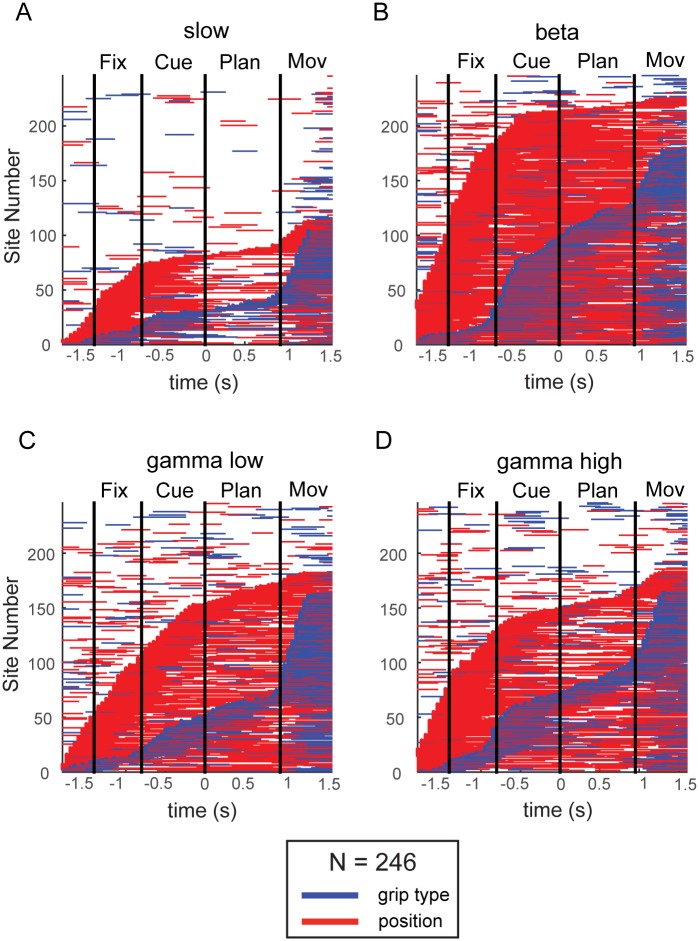
Tuning Onset.Sliding window analysis (window size 300ms, step size 50ms, two-way ANOVA, p < 0.05) in combined plots for both animals (N = 246 sites) revealed times with significant tuning in the slow frequency band (A), beta band (B), low gamma (C), and high gamma band (D). Horizontal lines indicate time periods with significant tuning for grip type (blue) and position (red), aligned to onset of the planning epoch. Sites are ordered by tuning onset (defined by the appearance of at least five consecutive significant steps). Vertical lines mark the border of the fixation, cue, planning, and movement epoch.